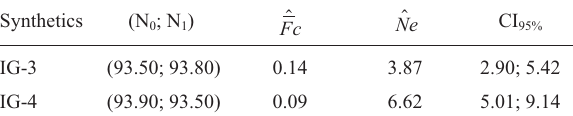
$ Fc : mean standardized variance in allele frequency weighted over loci.